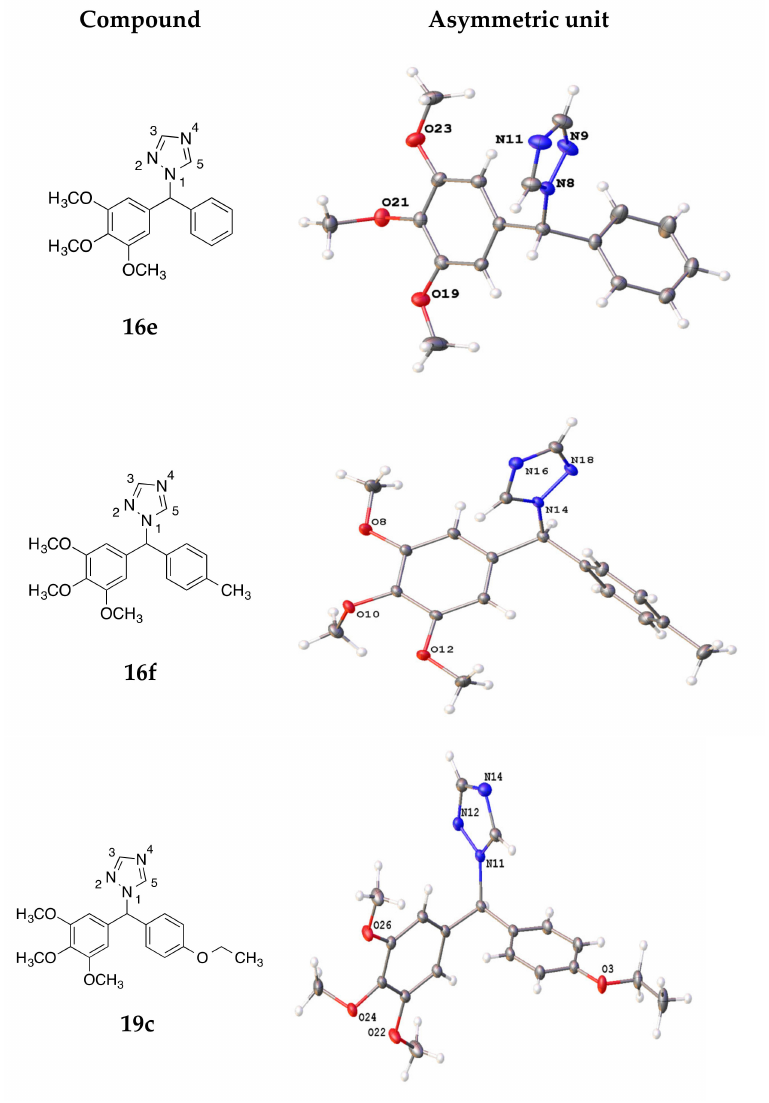
Figure 2. X-ray crystallography structures of 16e , 16f , and 19c with heteroatoms labelled and displacement shown at 50%